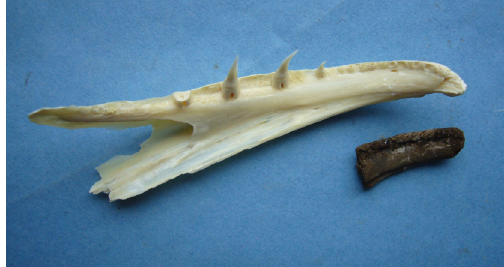
Figure 5. Cut marks on front portion of pike jaws, photo Maria